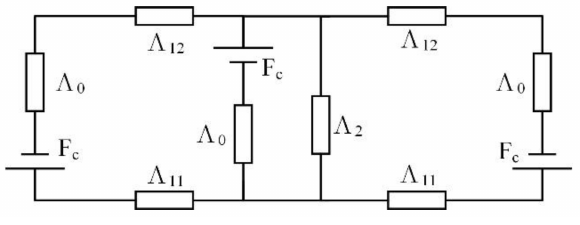
Figure 6. The equivalent magnetic circuits of the magnetic flux generated by the center permanent magnet